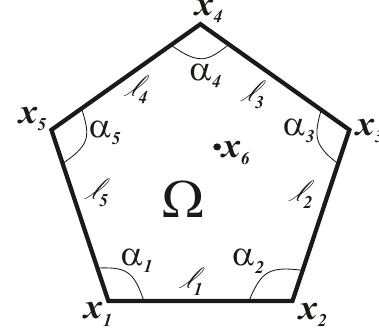
Figure 1. Example of a 2D configuration made by six landmarks, with the first five lying on the boundary and one, x 6 , inside the region Ω